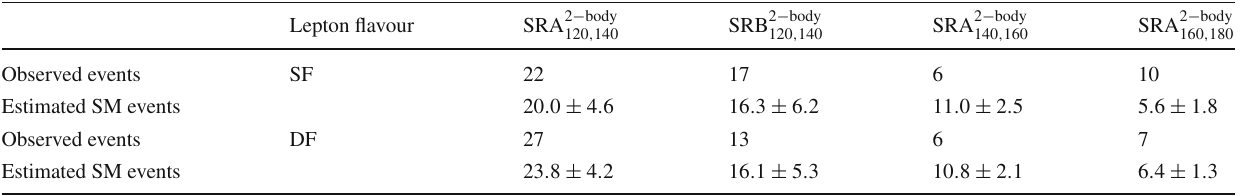
− body Table 16 Two-body selection background fit results for SR ( A , B ) 2 x , y regions, where x and y denote the low and high edges of the bin. Combined statistical and systematic uncertainties are given. Uncertainties in the predicted background event yields are quoted as being